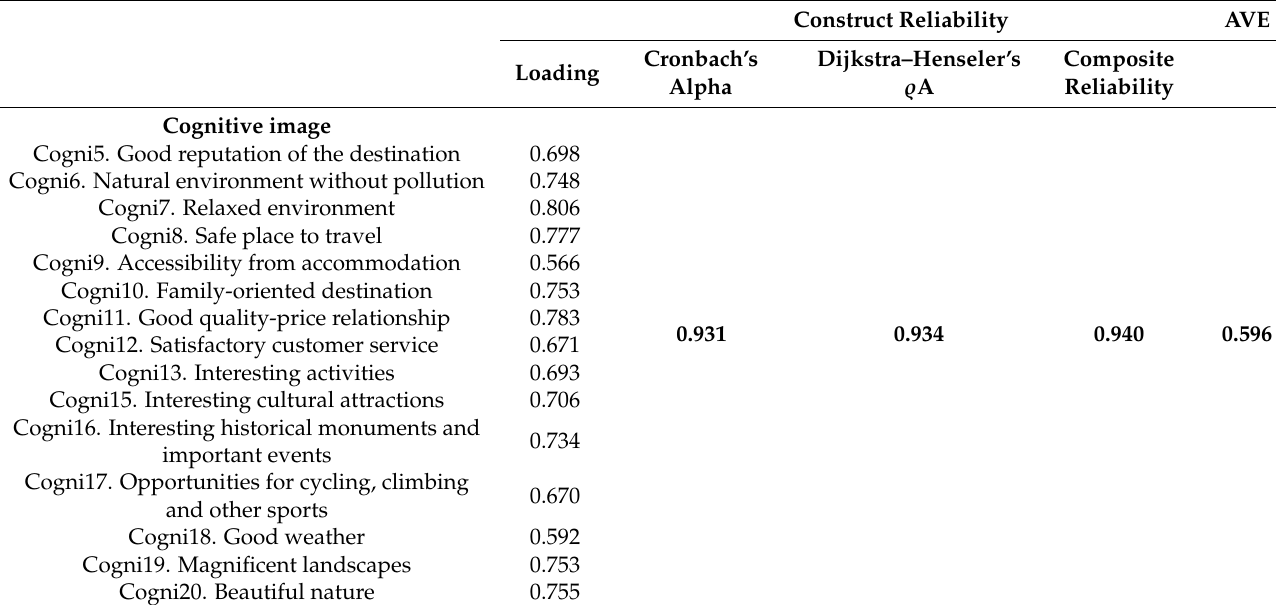
Table 3. Reflective constructs and their corresponding